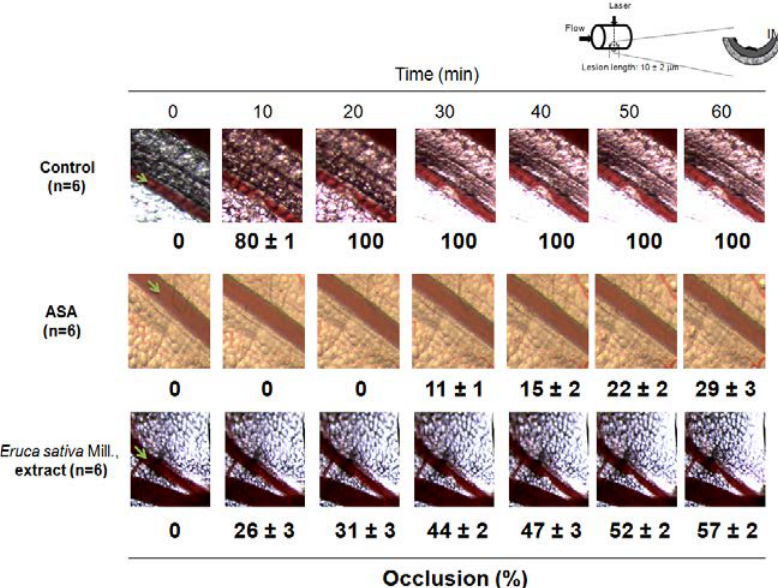
Figure 6. Eruca sativa Mill. extract inhibited arterial thrombosis formation. Representative images of thrombus formation after laser irradiation in the vehicle (DMSO 0.2%) control group ( n = 6), ASA (acetylsalicylic acid; 200 mg/kg; n = 6) and Eruca sativa extract (200 mg/kg, n = 6) to 60 min. Each photograph represents the percentage of occlusions caused by thrombus formation. I, intima; M, media; A,